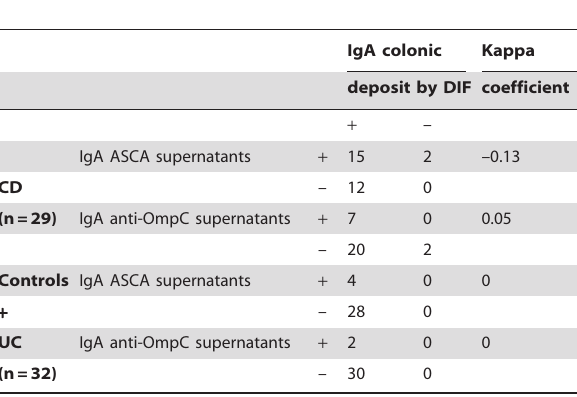
Table 2. Study of IgA intestinal deposit and ASCA/anti-OmpC antibody detection in supernatants for each clinical